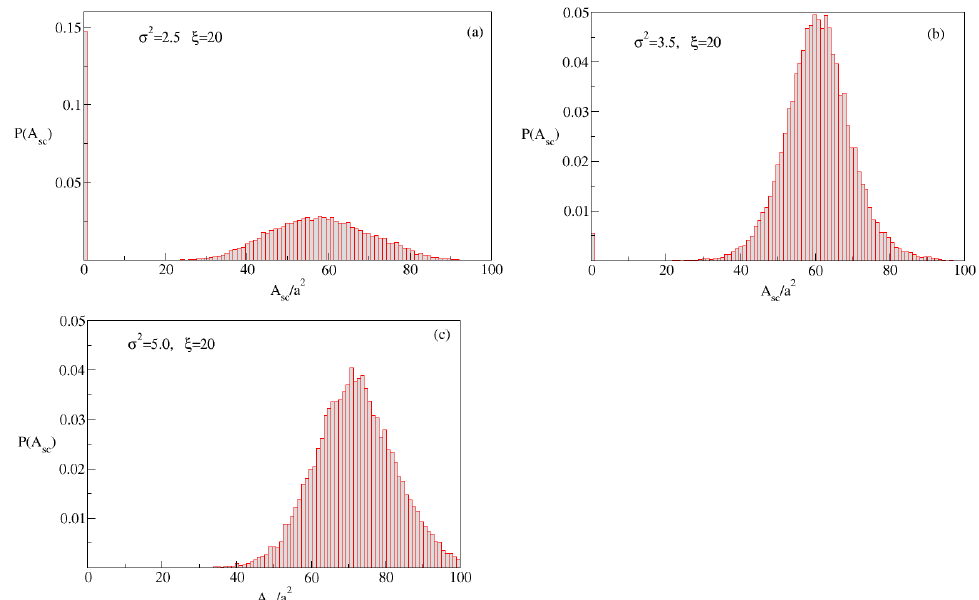
Figure 8. One thousand simulations were performed and at the end of each, the area of contact A sc between the largest cluster (corresponding to λ = 100) and the substrate was determined. These values were used to estimate the probability P ( A ) of observing substrate-cluster contact area A and the results are shown here for substrates with correlation length ξ = 20 and variances σ 2 = 2.5 ( a ), σ 2 = 3.5 ( b ) and σ 2 = 5.0 ( c ). The probability to observe clusters with no contact with the substrate ( P ( 0 ) > 0) decreases with increasing